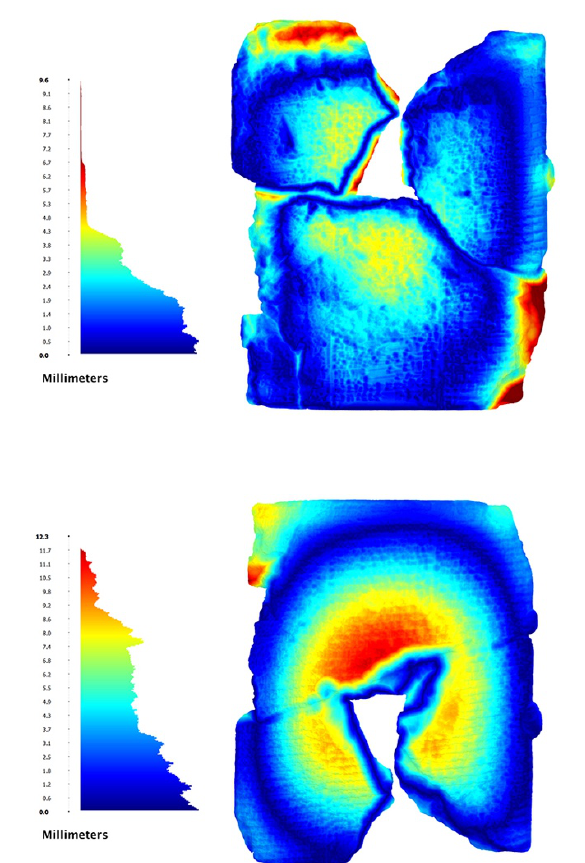
Figure 4. Color representations of Hausdorff distances from the obverse and reverse photometric stereo 3D models to the structured light 3D